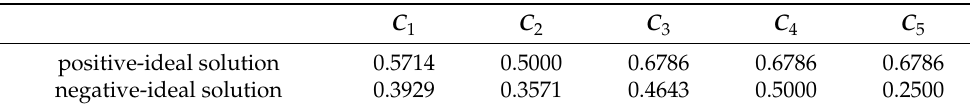
Table 7. Positive-ideal solution and negative-ideal solution.